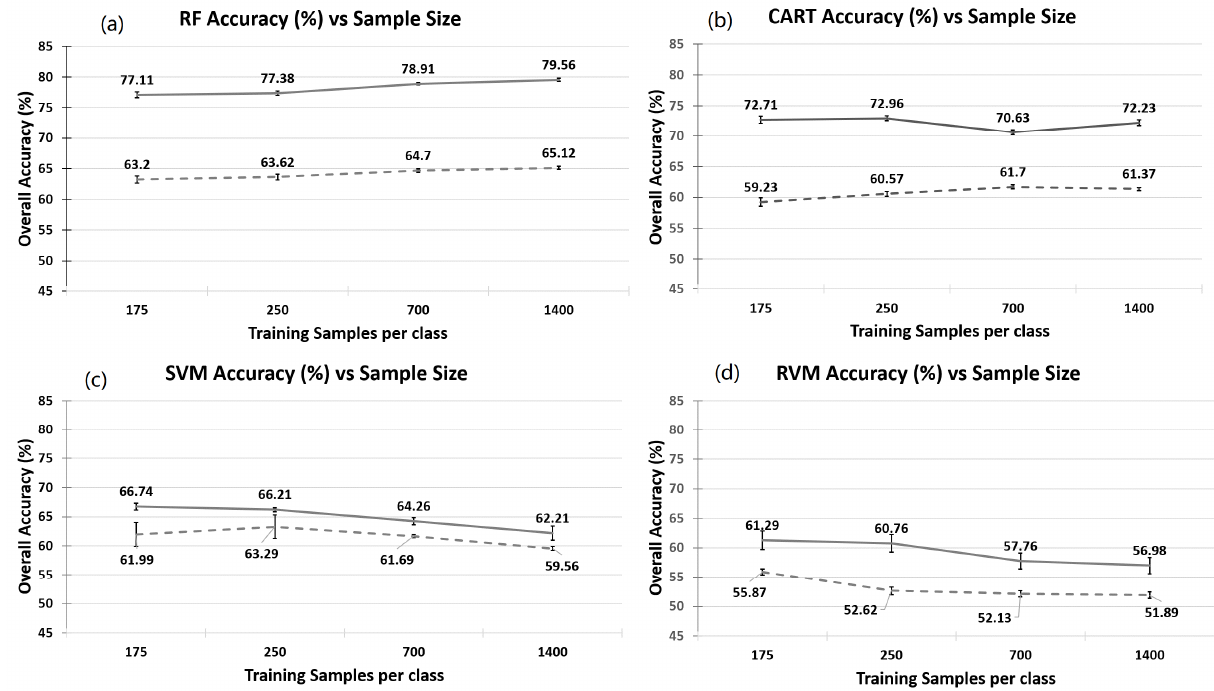
Figure 7. Average overall accuracy obtained for different classifiers using different training sample sizes per class and datasets (D-1, D-2): ( a ) RF classifier, ( b ) Classification and Regression Trees (CART) classifier, ( c ) Support Vector Machine (SVM) classifier, and ( d ) RVM classifier. The error bars indicate the standard deviation of overall accuracy for 100 trials .